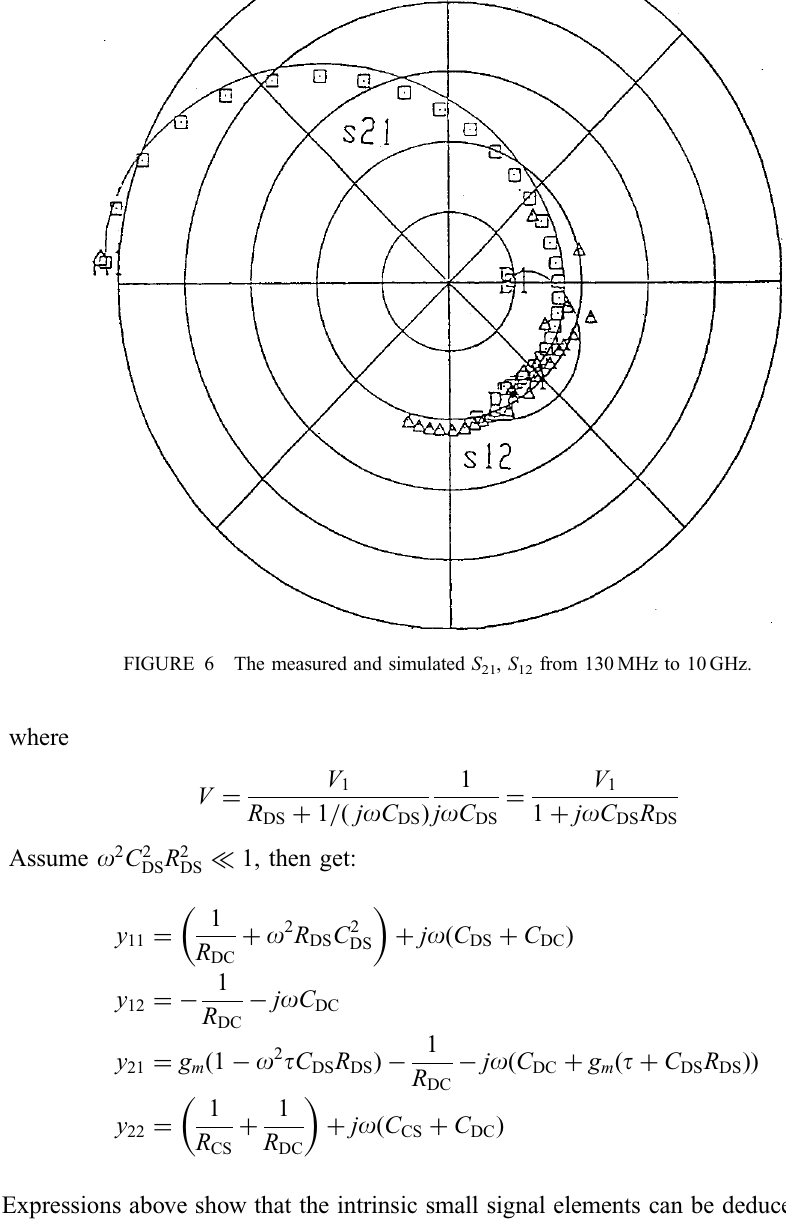
Figure 6. The f T and f max of the studied RSTT is near 2 GHz, so the simulated frequency is chosen from 130 MHz to 1.52 GHz. The fitting results are shown in Table II. We get